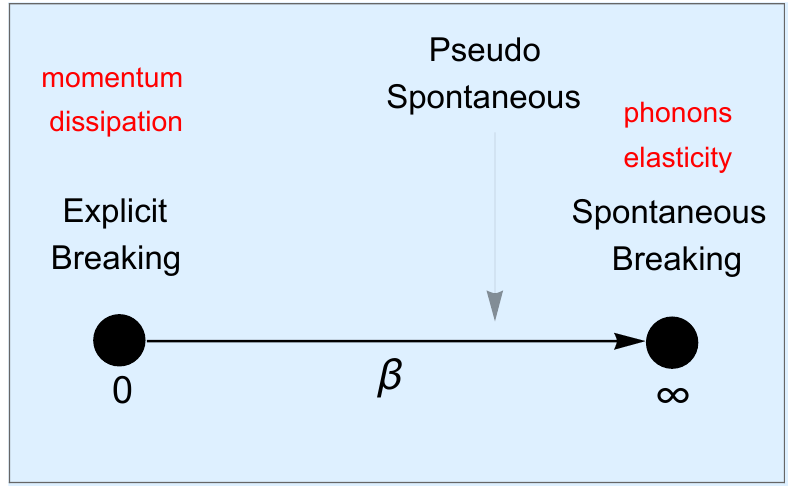
Figure 2 . A cartoon for the benchmark model (2.6). The parameter (cid:12) allow to continuously move from an explicit breaking situation towards a purely spontaneous one. Most of the computations of this work will focus on the pseudo-spontaneous regime de(cid:12)ned as the limit (cid:12) (cid:29)